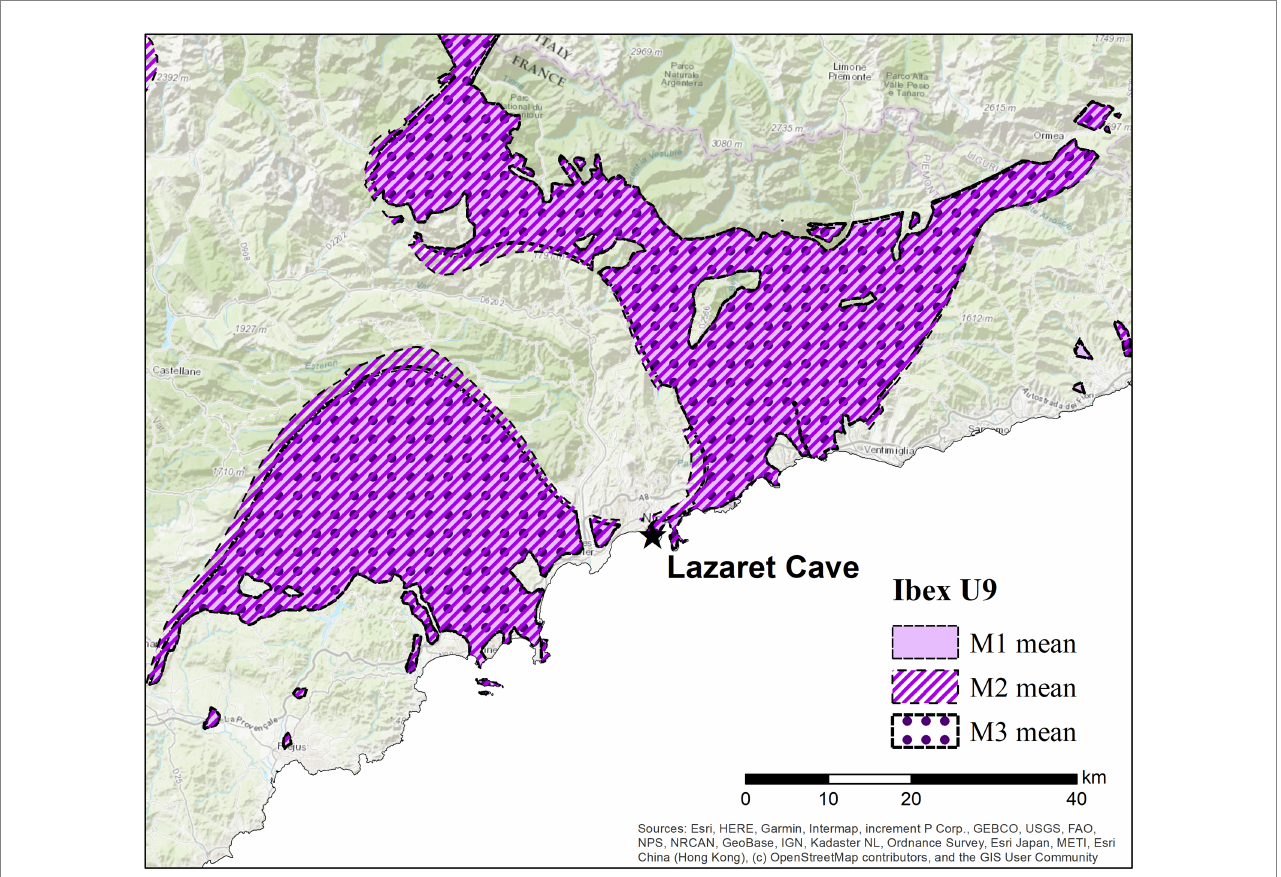
FIGURE 8 Spatial assignment of strontium isotope data from ibex first, second and third molars from Lazaret Cave. Star indicates location of Lazaret Cave. As there was no variation in 87 Sr/ 86 Sr values across the molars, the mean of each tooth was assigned. The M1 is show as a solid colour, while M2 is shown by diagonal lines and the M3 is represented by circles so that all overlapping rangers can be identified. The landscape shown in this image is within the dashed rectangle in Figure 4; Esri